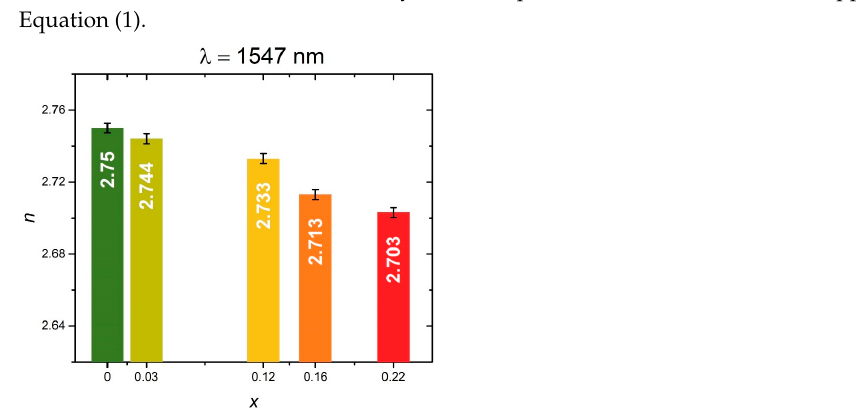
Figure 2. Ordinary refractive index of GaSe:S crystals measured at a wavelength of 1547 nm.